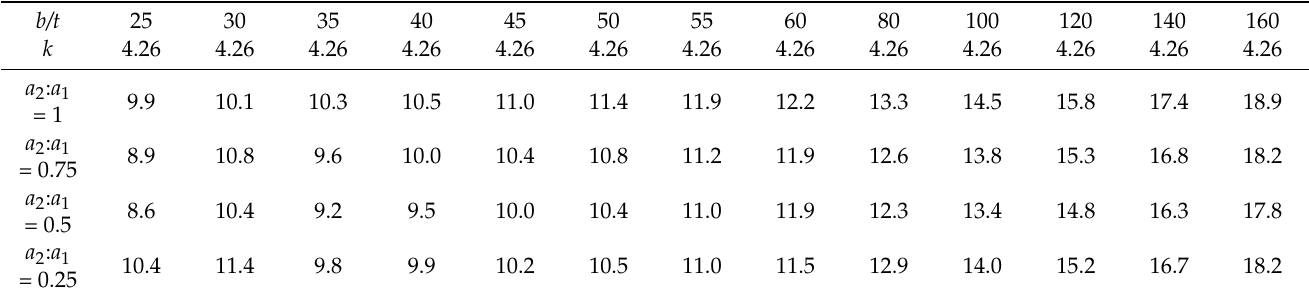
Table 5. Values of k and l/t for Q235.